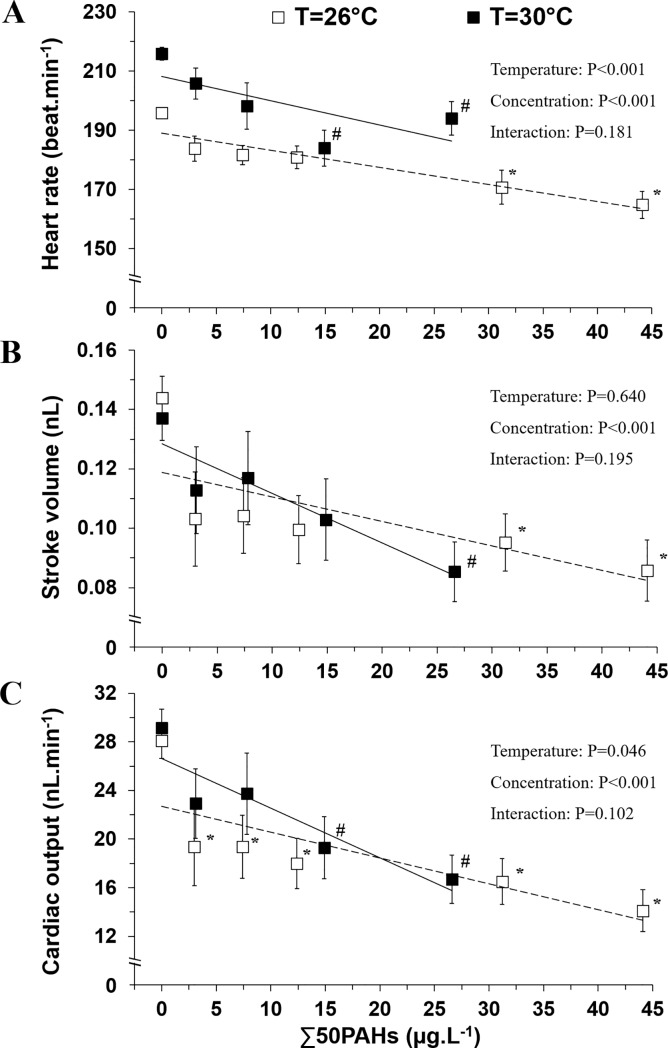
Cardiac variables measured in mahi larvae under combined oil and temperature exposures.(A) Heart rate (beat.min-1), (B) stroke volume (nL) and (C) cardiac output (nL·min-1) measured at two rearing temperatures 26°C (N = 20–39) and 30°C (N = 20–56). Data are presented as Mean±SEM. Simple linear regressions are given for graphical representation at both temperature exposures. * for 26°C and # for 30°C indicate significant differences of oil exposure concentrations compared to respective control groups (P<0.05).